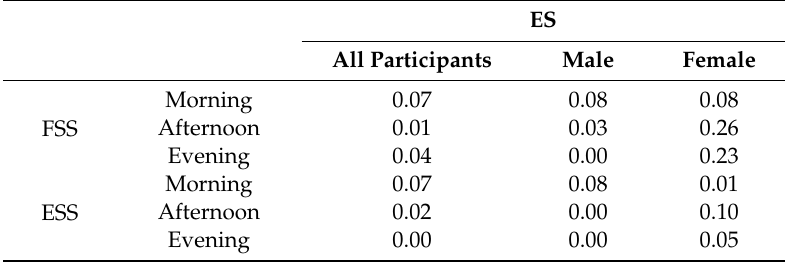
Table 4. ES of fatigue and sleepiness scores during RF in the morning, afternoon and evening between T1 and